Question: Does the plotted quantity increase or decrease?
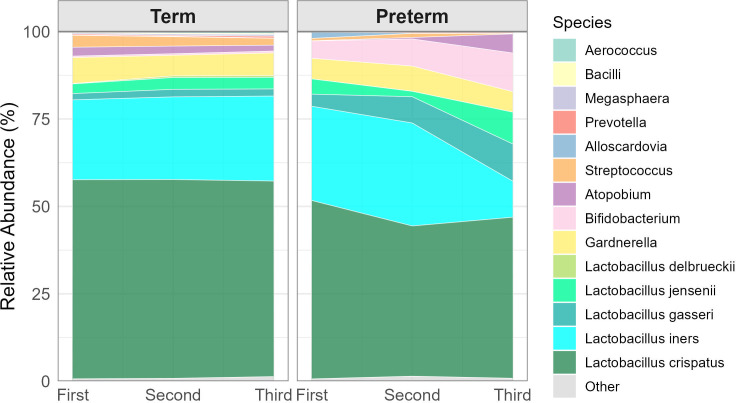
Answer: increasing